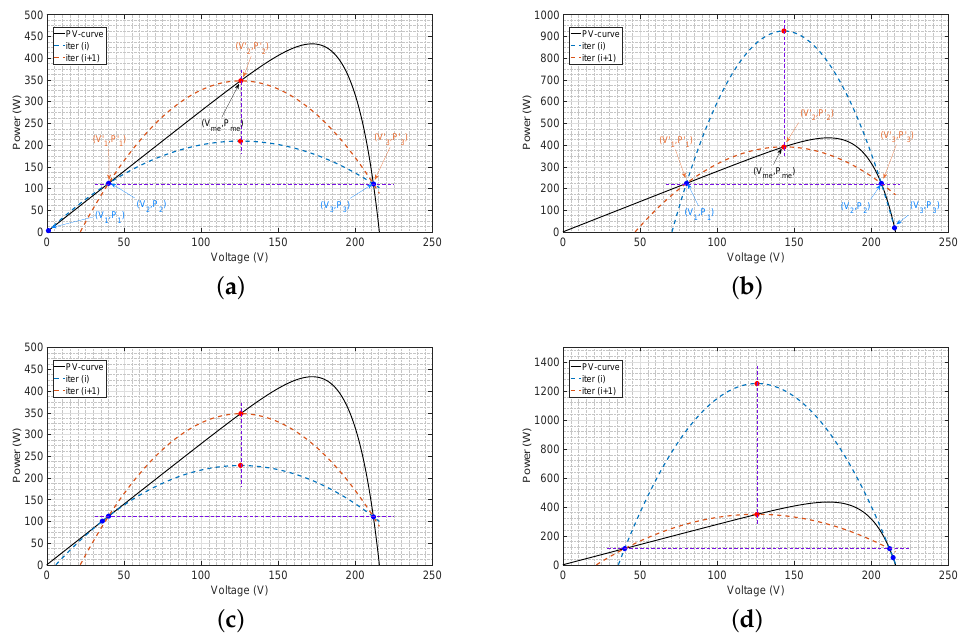
Figure 17. The “NQI trap” occurs when two IPs have the same power level and the third has the lowest power. ( a , b ) lowest power IP is below the left point; ( c , d ) lowest power IP is below the right